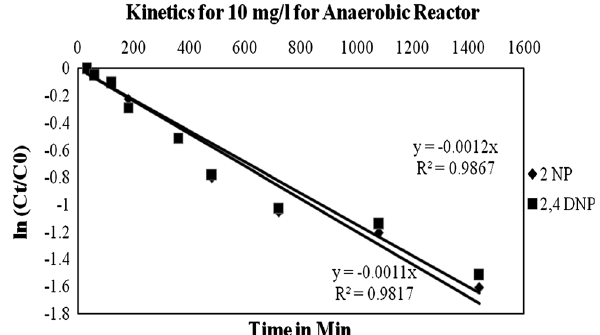
Fig. 8 Nitrophenol removal of anaerobic reactors with redox media- tors